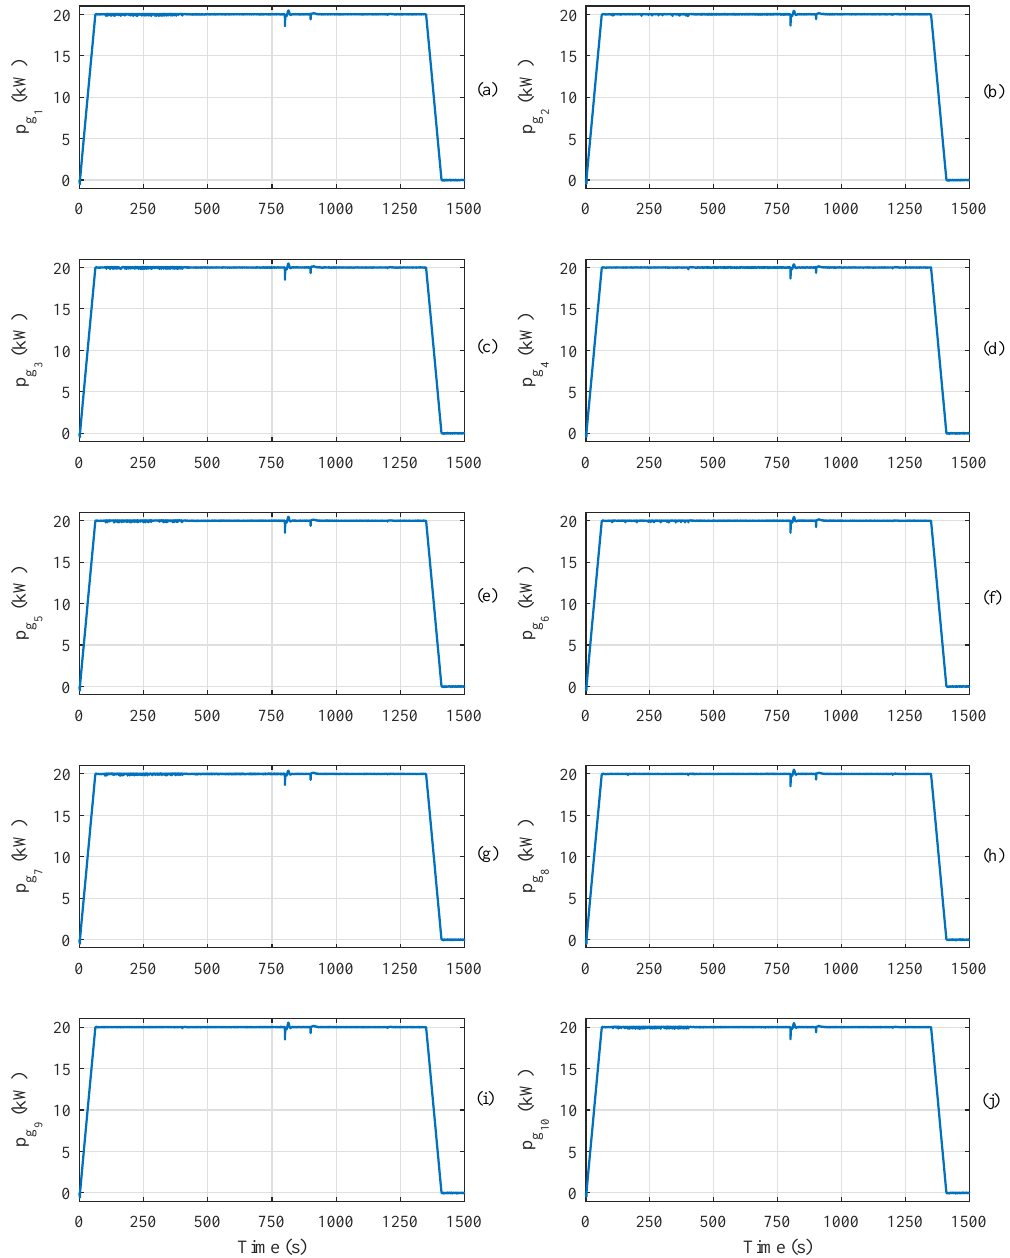
Figure 13. Individual time responses of the power generated by the 10 tracker–hybrid energy storage system (HESS) units. ( a ) p g